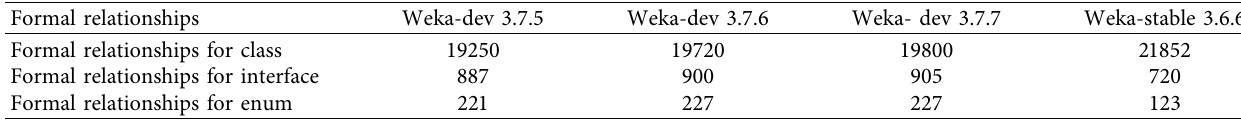
Table 23: Formal relationships in weka.